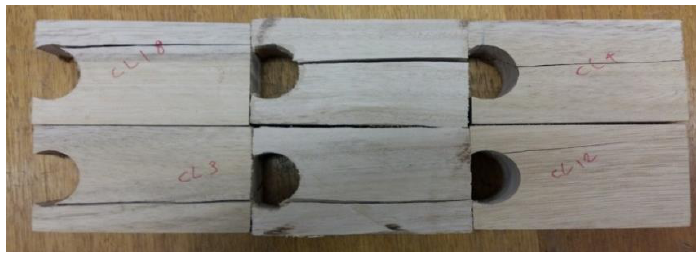
Figure 6. Failure modes of cleavage samples.